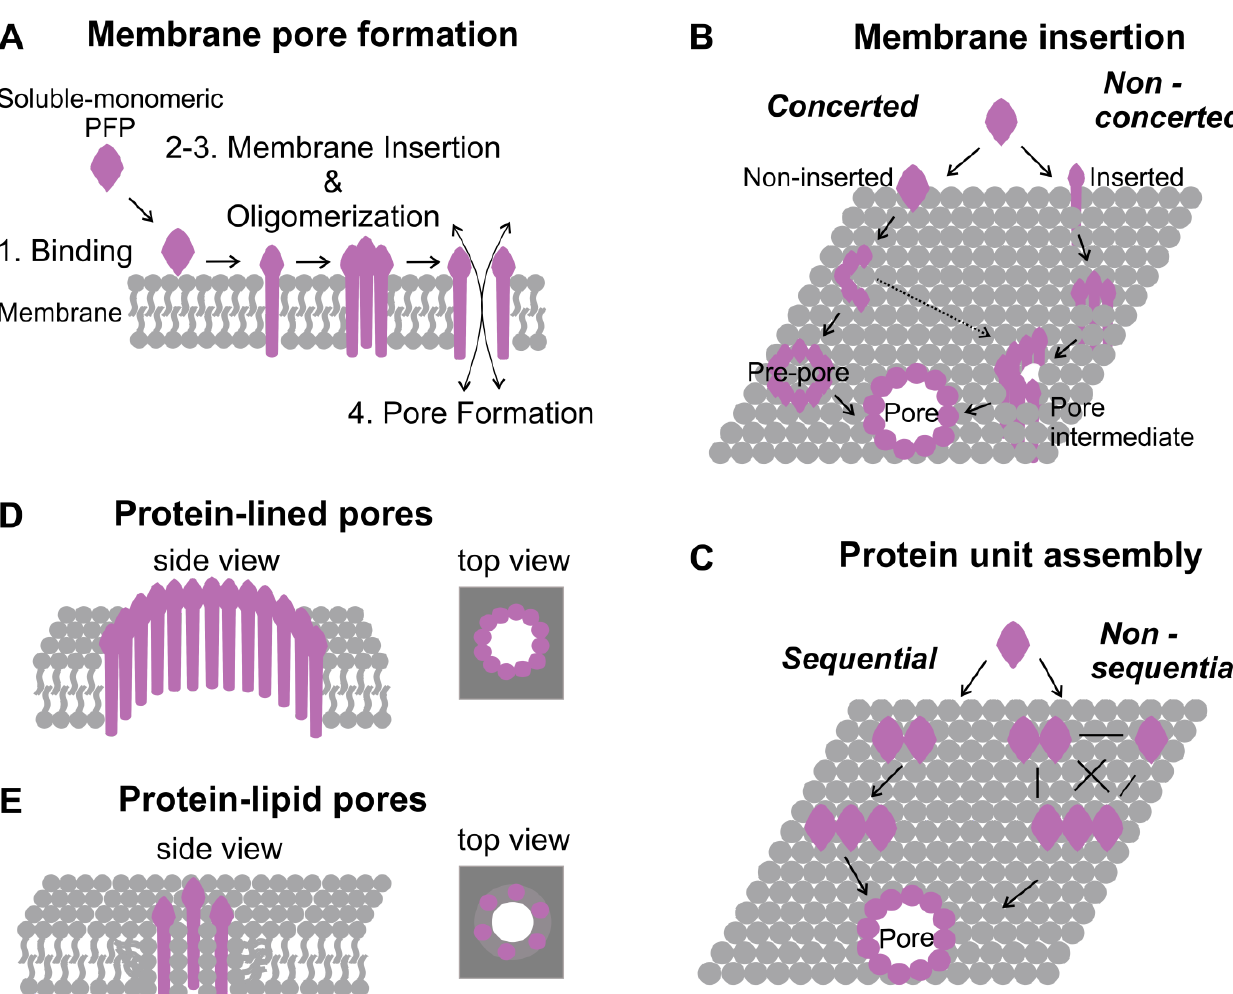
Figure 1. Mechanism of pore formation by PFPs. ( A ) Model of membrane pore formation that involves an initial membrane-protein binding, followed by protein conformational changes that trigger membrane insertion and oligomerization and the final pore formation (details are in the text). ( B ) Mechanism of membrane insertion: concerted vs. non-concerted. In the concerted model of insertion, oligomerization takes place in the first step, leading to the formation of a “pre - pore” above the membrane, while membrane insertion occurs consequently by concerted conformational changes in all protein units. Intermediate non-inserted structures can also insert generating pores (dashed line)In the non-concerted model, protein monomers bind to the membrane, and membrane insertion occurs before or during oligomerization. In this case, intermediate structures can already permeabilize the membrane. ( C ) Mechanism of protein assembly: sequential vs. non-sequential. Protein oligomerization can occur via the sequential addition of units of fixed stoichiometry or by the random (non-sequential) addition of units of different stoichiometries. ( D , E ) Schematic representation of protein-lined ( D ) and protein-lipid ( E ) pores. Protein-lined pores are exclusively formed by proteins, while the protein-lipid pore structure derives from the cooperation of both protein and lipids. Lipids are represented in gray and proteins in pink.